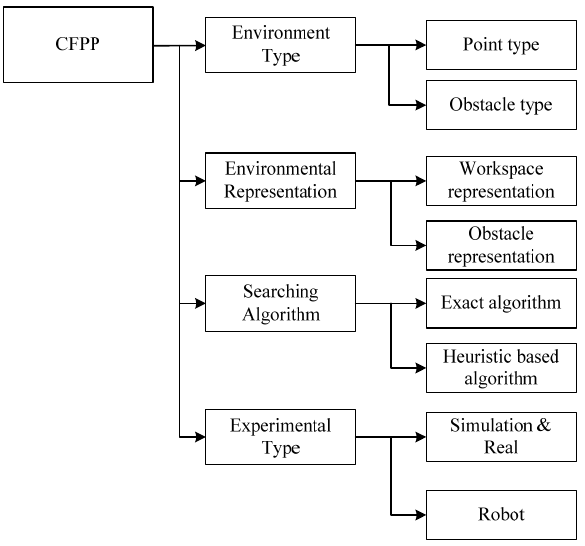
Figure 1. Characteristics of the collision-free path planning (CFPP).